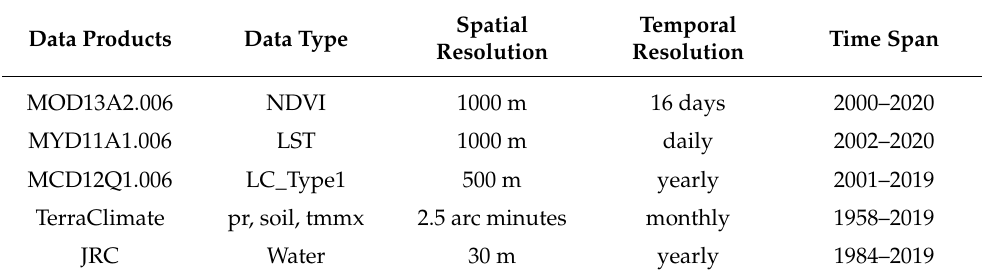
Table 2. Main data used in this